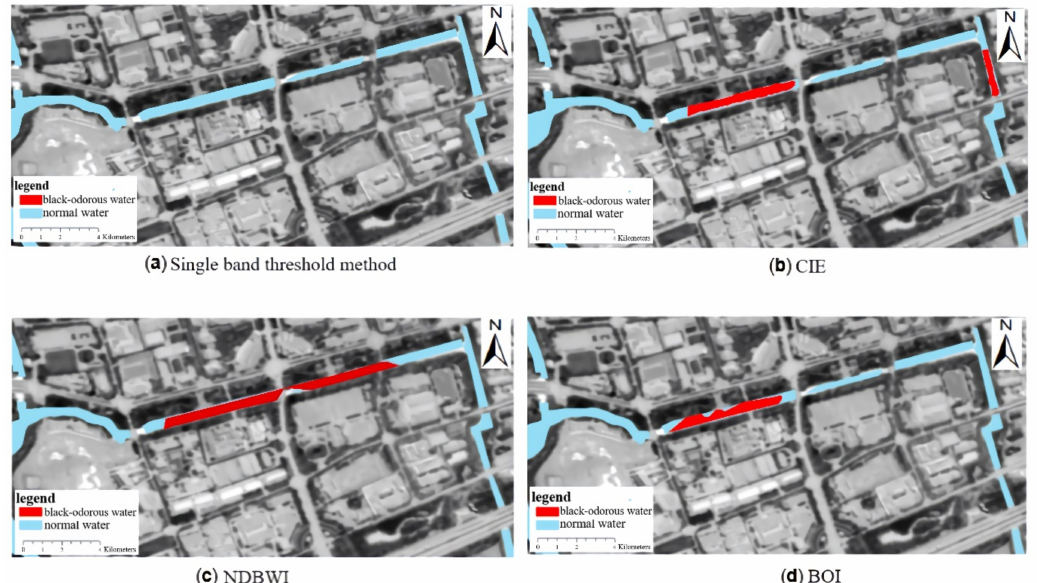
Figure 10. Recognition results of black-odorous water by different algorithms.